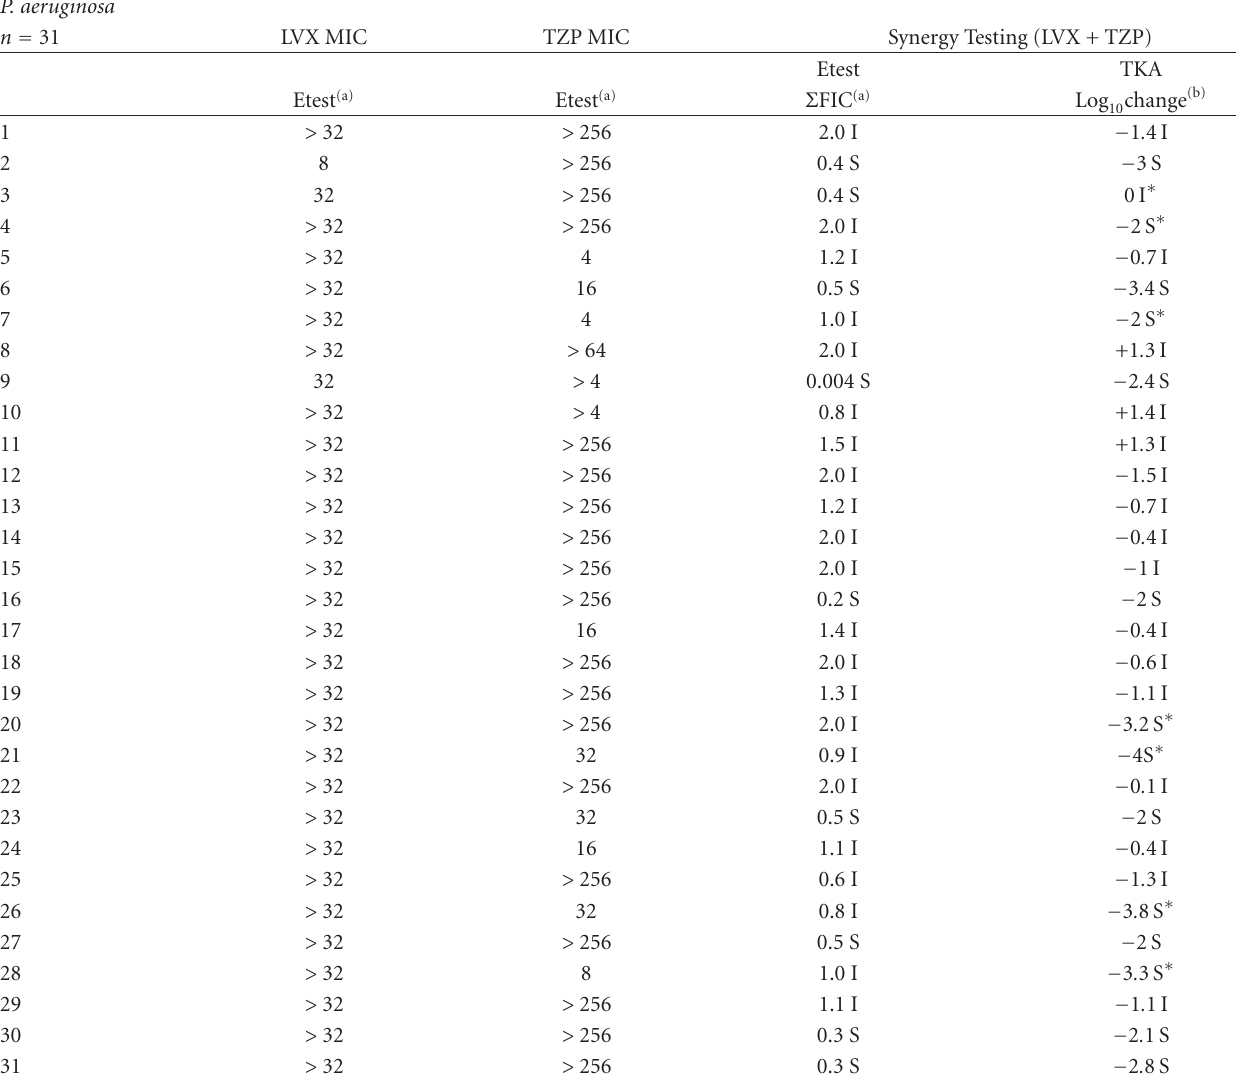
Table 1: Etest MIC ( μ g/mL), Etest Synergy Method, and Time-Kill